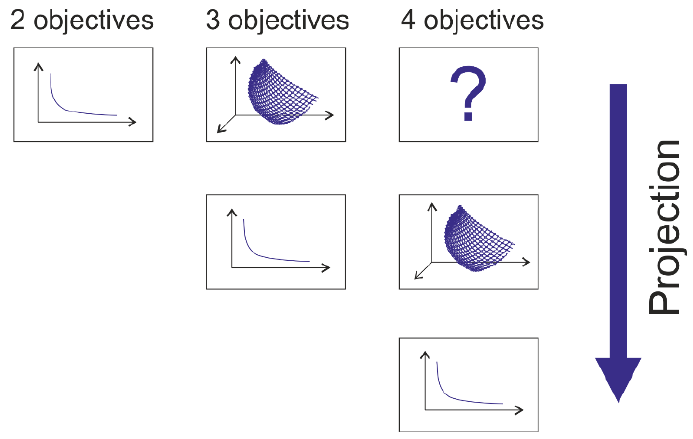
Figure 8. Visualization of the Pareto front for the different number of objectives.